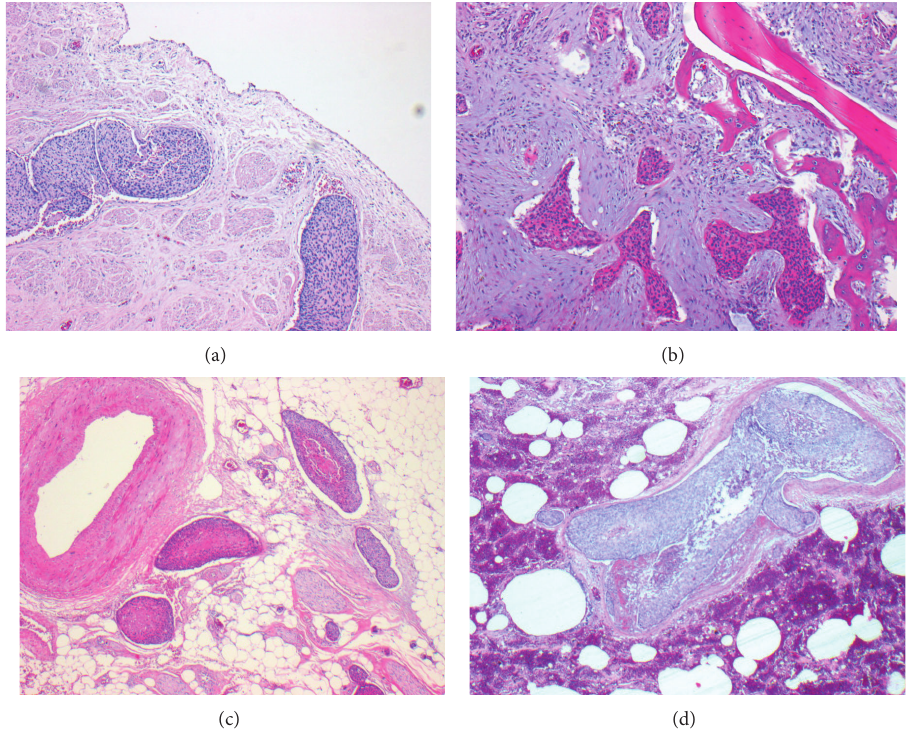
Figure 2: (a) Squamous cell carcinoma manifestation in the ureteral wall. (b) Metastatic manifestation of the squamous cell carcinoma lesion in the vertebral body. (c) Tumour infiltration of periurethral fat tissue. (d) Pulmonary vessels with extensive squamous cell carcinoma tumour embolisms and haemorrhagic infarction of the pulmonary